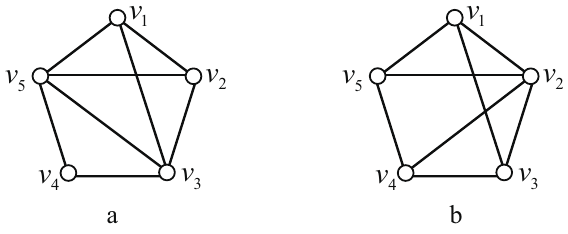
Figure 9. Graphs of d ( G ) = 2, n ( G ) = c ( G ) = 5 and | E ( G ) | = 8. For a , v 3 and v 5 are adjacent; for b , v 2 and v 4 are